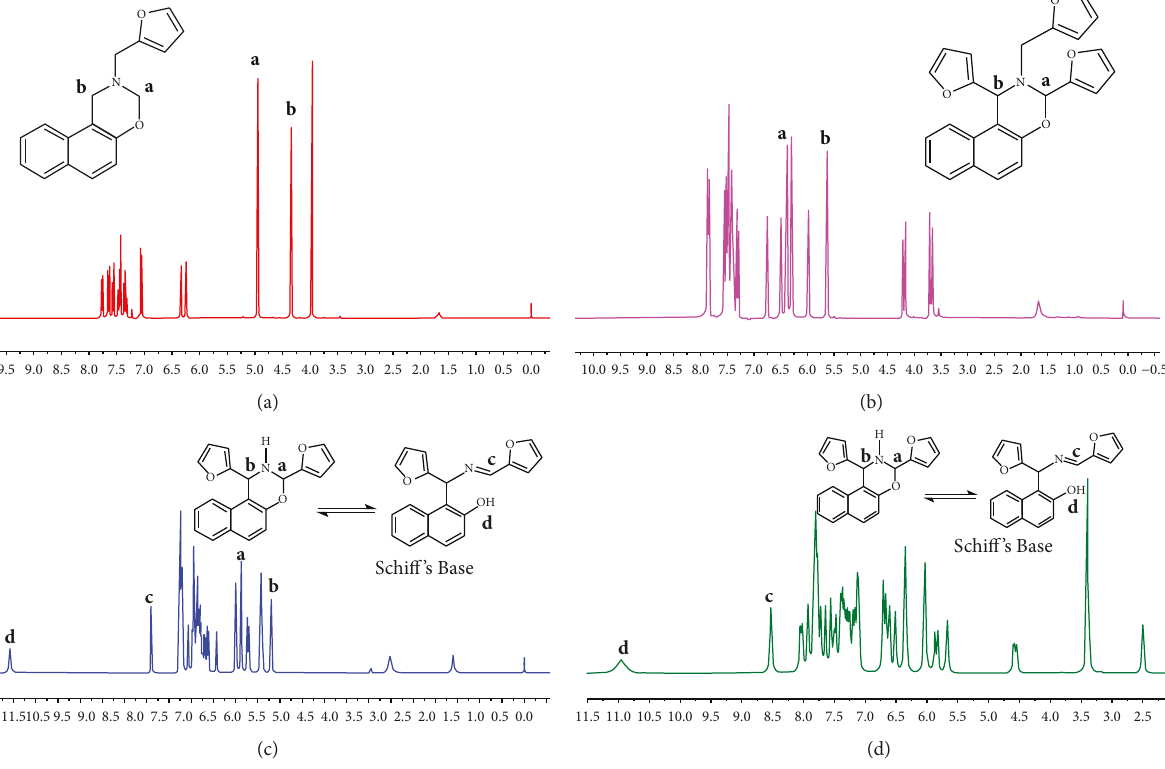
Figure 5: 1 H NMR of naphthoxazines containing furan groups. (a) Naft-Fu-H, (b) Naft-Fu-Fu, (c) Naft-H-Fu, and (d) Naft-H-Fu (in DMSO-d 6